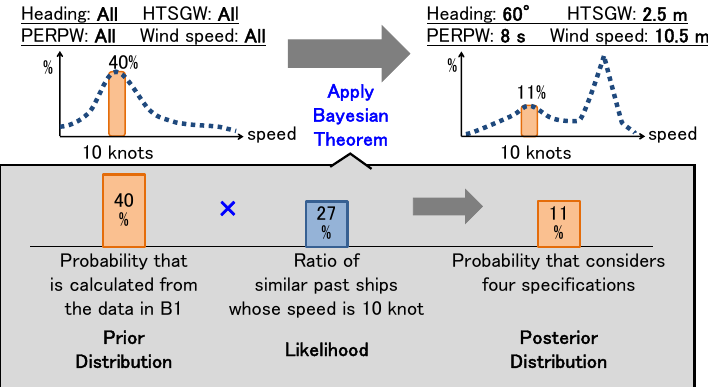
Figure 8. Using Bayesian learning to estimate the voyage speed distribution.